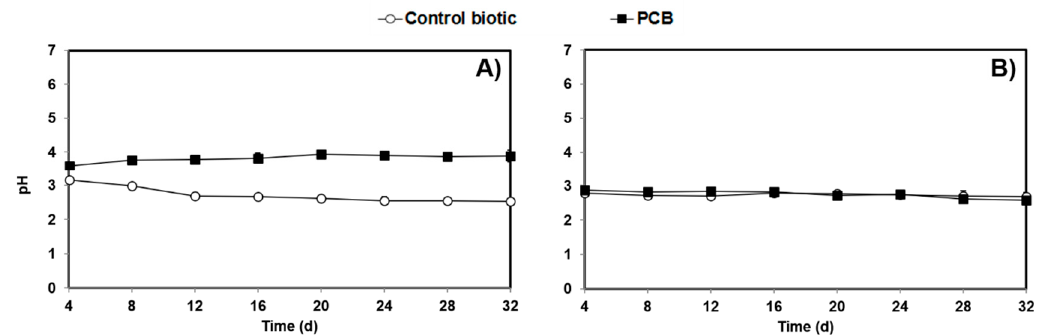
Figure 4. Behavior of pH in the culture medium of treatments with and without PCB: ( A ) A. niger MXPE6; ( B ) fungal consortium ( A. niger MXPE6 + A. niger MX7). Data are given as means ± standard error; n = 3.